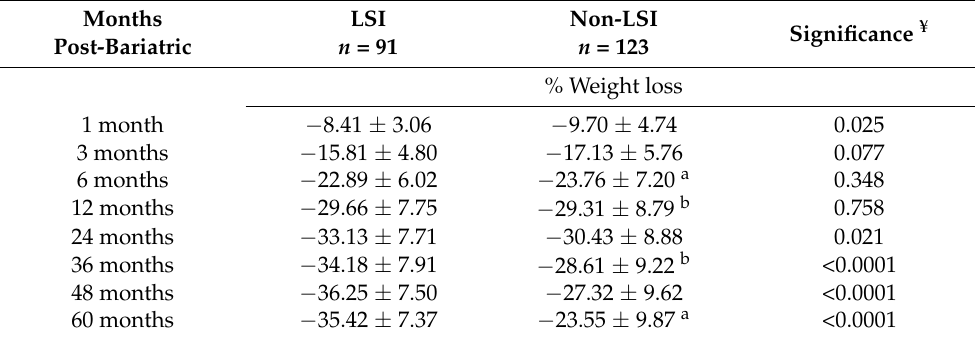
Table 2. WL% at different time points among participants in the two groups ( n =